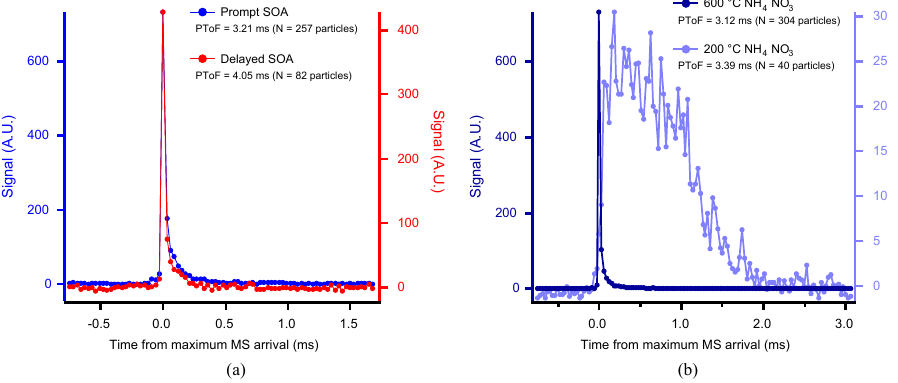
Figure 8. Mass spectral signal profiles for two (prompt and delayed) PToF arrival times for SOA. Profiles of single-particle mass arrival for SOA (a) and ammonium nitrate particles (b) under different vaporization scenarios. (a) Plot shows total chemical ion detection as a function of time from arrival of maximum signal for SOA. The traces represent the average signal for all particles with the same MS arrival time. The two arrival time bins shown correspond to either all prompt (PToF bin = 3.21ms, blue trace) or delayed (PToF bin = 4.05ms, red trace) particles. N is the number of particles used to make the average trace. (b) Similarly, average chemical signals as a function of arrival time are shown for ammonium nitrate particles at two different vaporizer temperatures. The arrival of mass at the detector (event length) is significantly longer for ammonium nitrate at 200 compared to 600 ◦